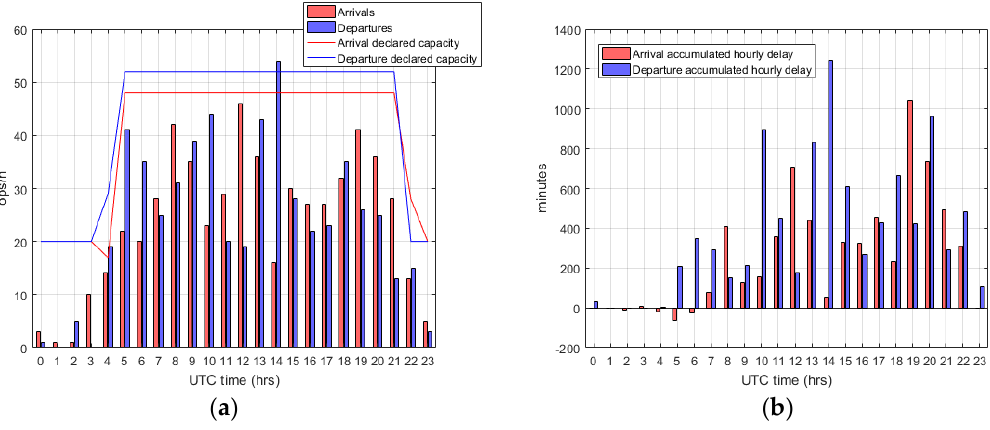
Figure 17. ( a ) Traffic demand profile (22 July 2016) and ( b ) arrival/departure accumulated hourly delay profile (22 July 2016).